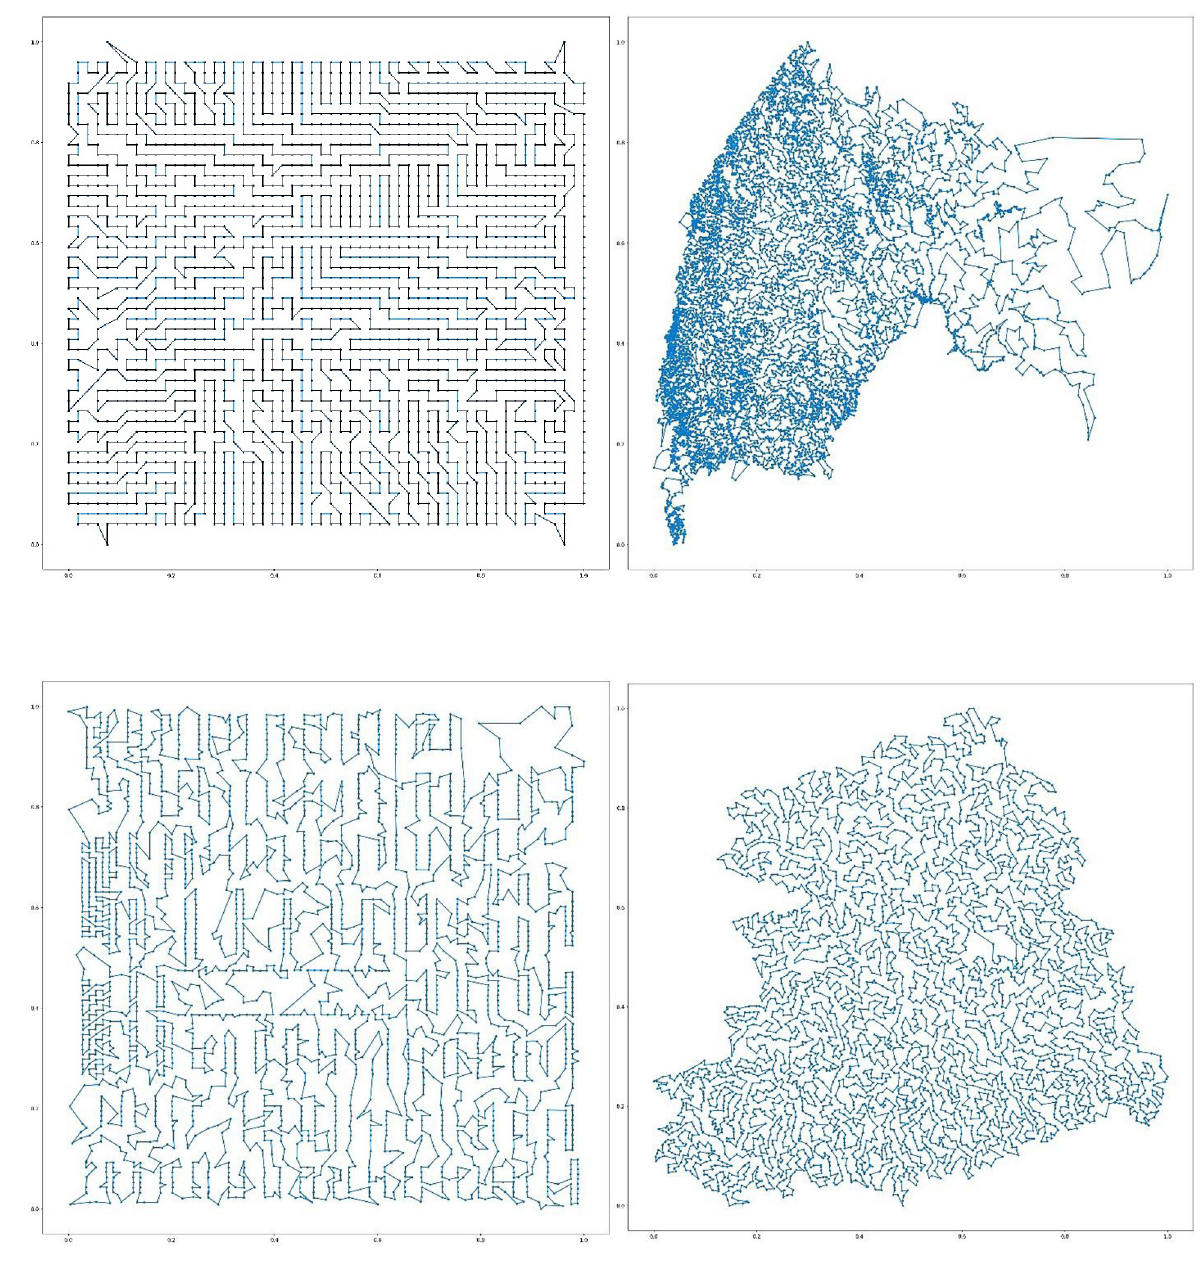
Fig 8. Sample tours for benchmark